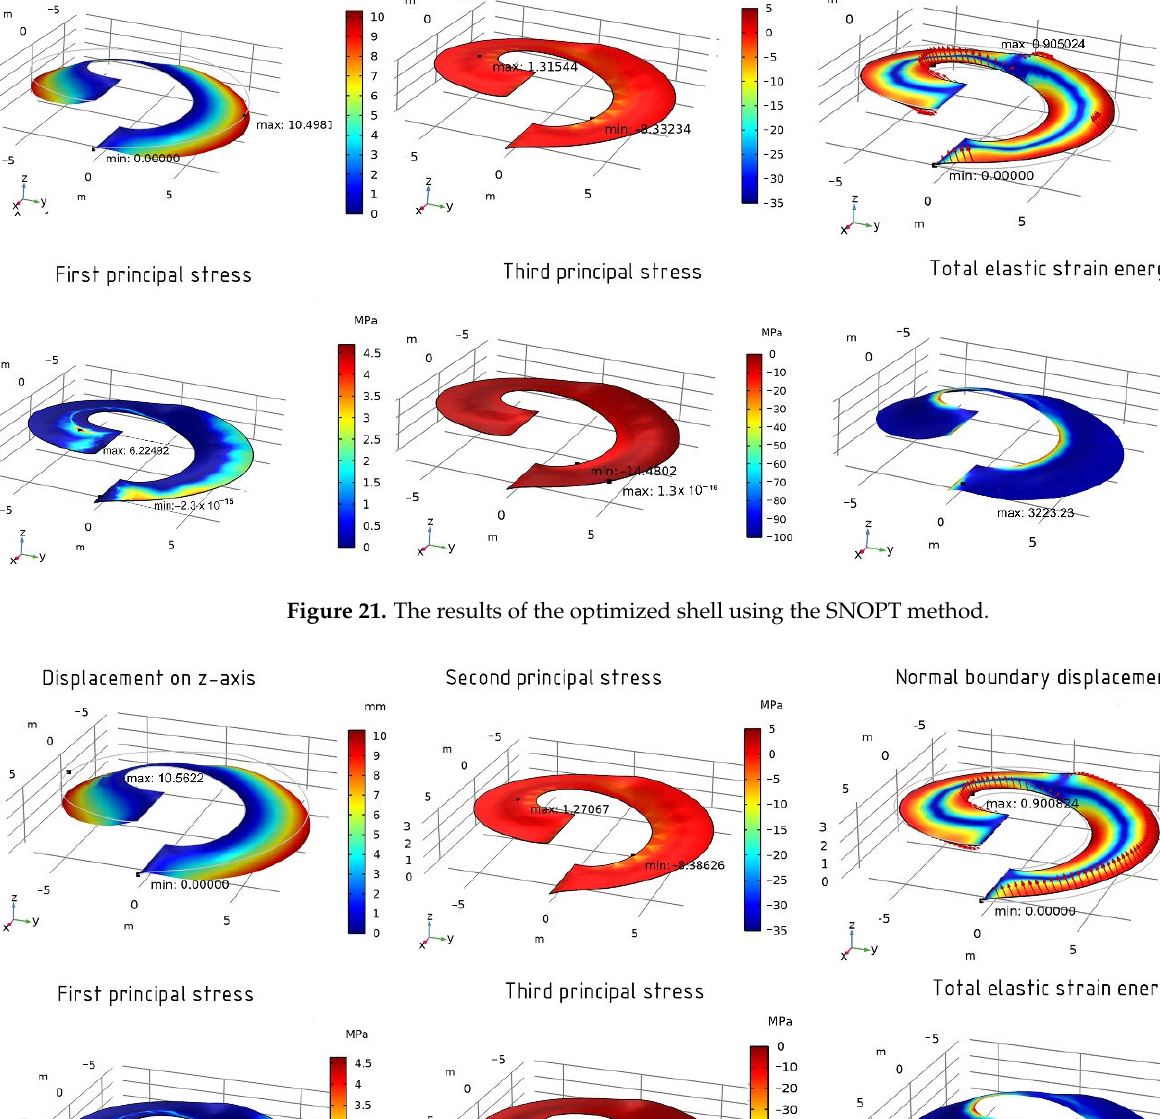
Table 4. Computational times for the three